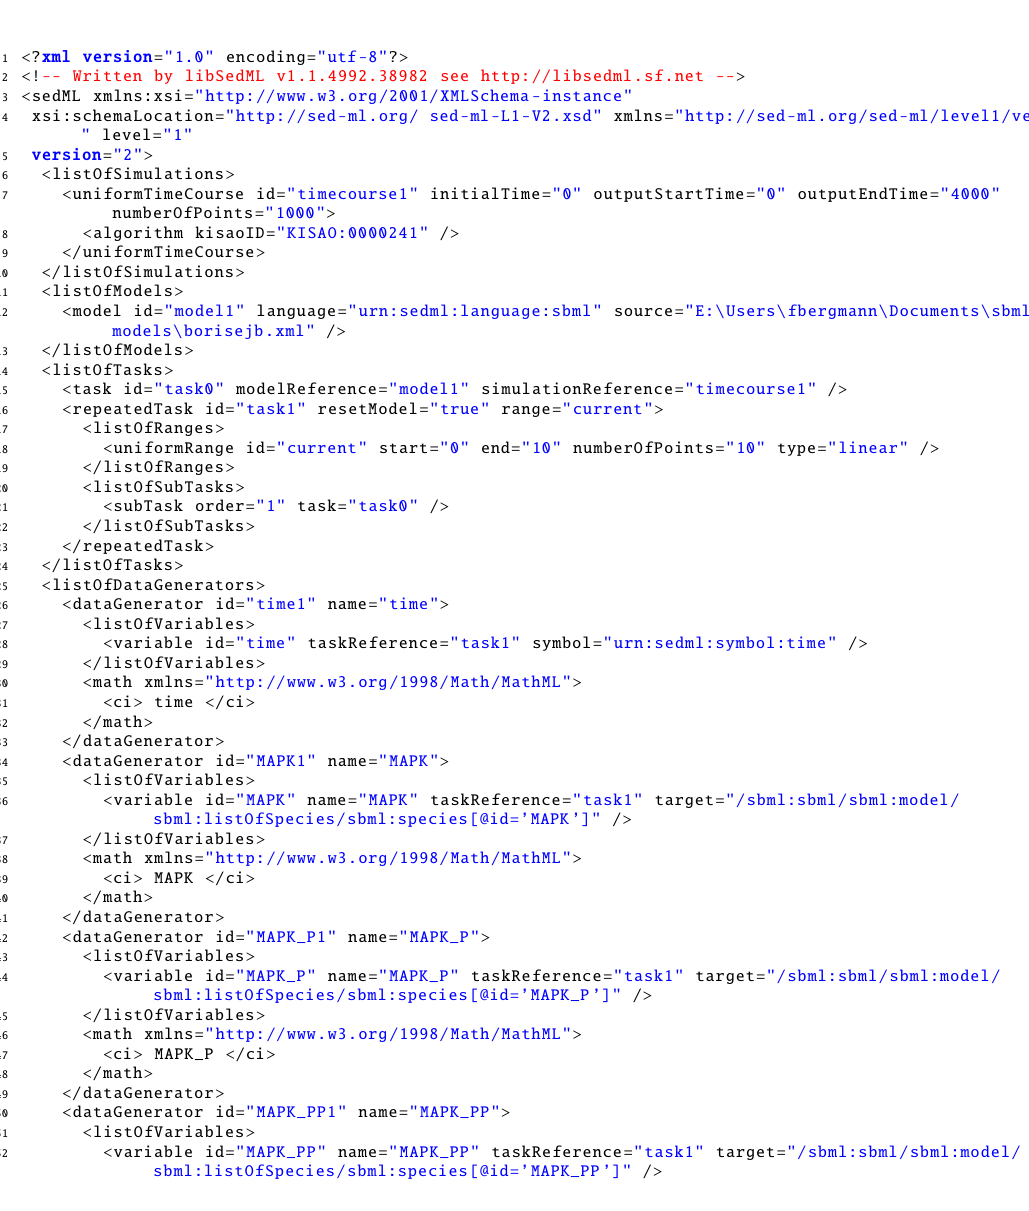
Figure C.6: The simulation result gained from the simulation description given in Listing